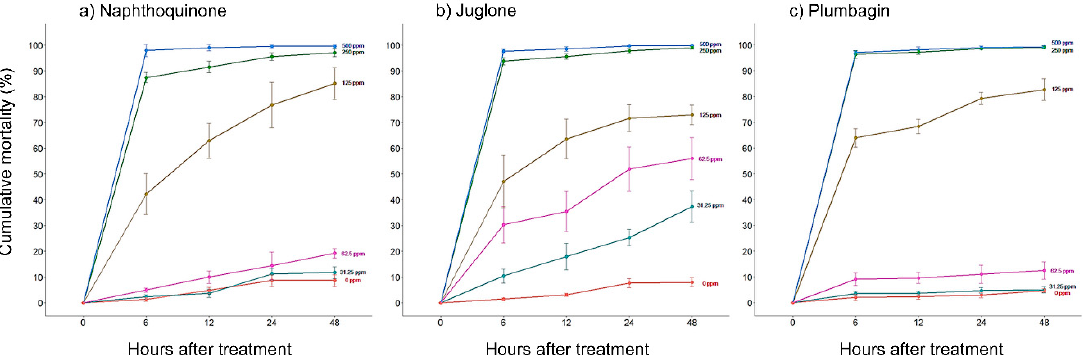
Figure 1. Cumulative mortality (%) in Bursaphelenchus xylophilus exposed to serial concentrations from 500 ppm to 31.25 ppm of ( a ) 1,4 ‐ naphthoquinone, ( b ) juglone, and ( c ) plumbagin. A 1% dimethyl sulfoxide (DMSO) solution was used as the control. Data are averages of six replicates, and bars represent standard deviations. Table 1. The median lethal concentration (LC 50 ) values of naphthoquinones against Bursaphelenchus xylophilus mixed development stages in vitro at 48 h after exposure to 1,4 ‐ naphthoquinone, juglone, and plumbagin. Compounds